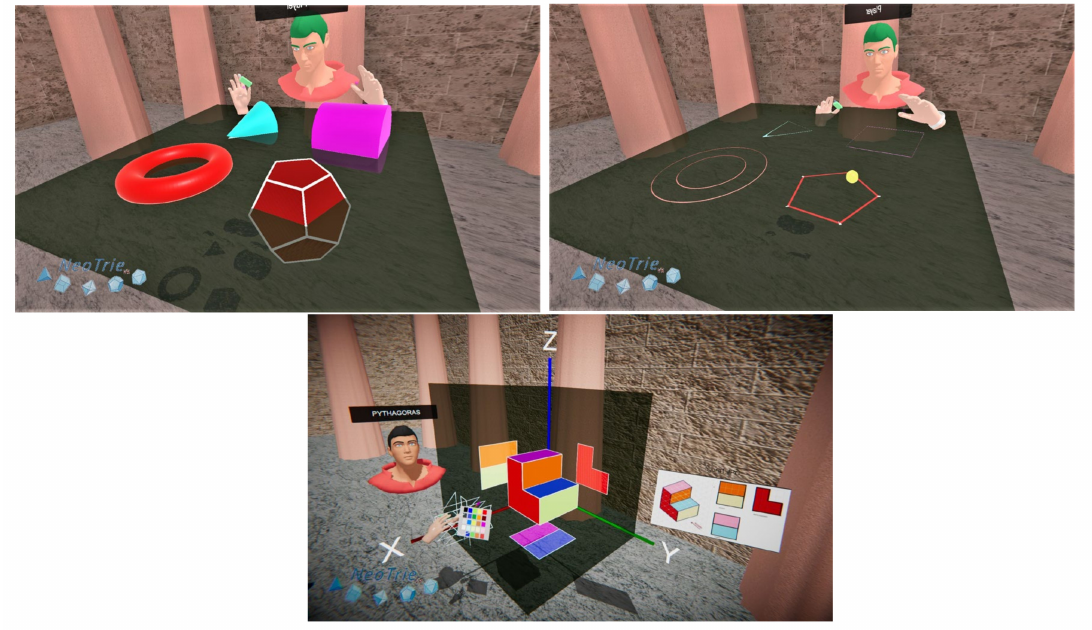
Figure 5. Scanner tools and a multi-view